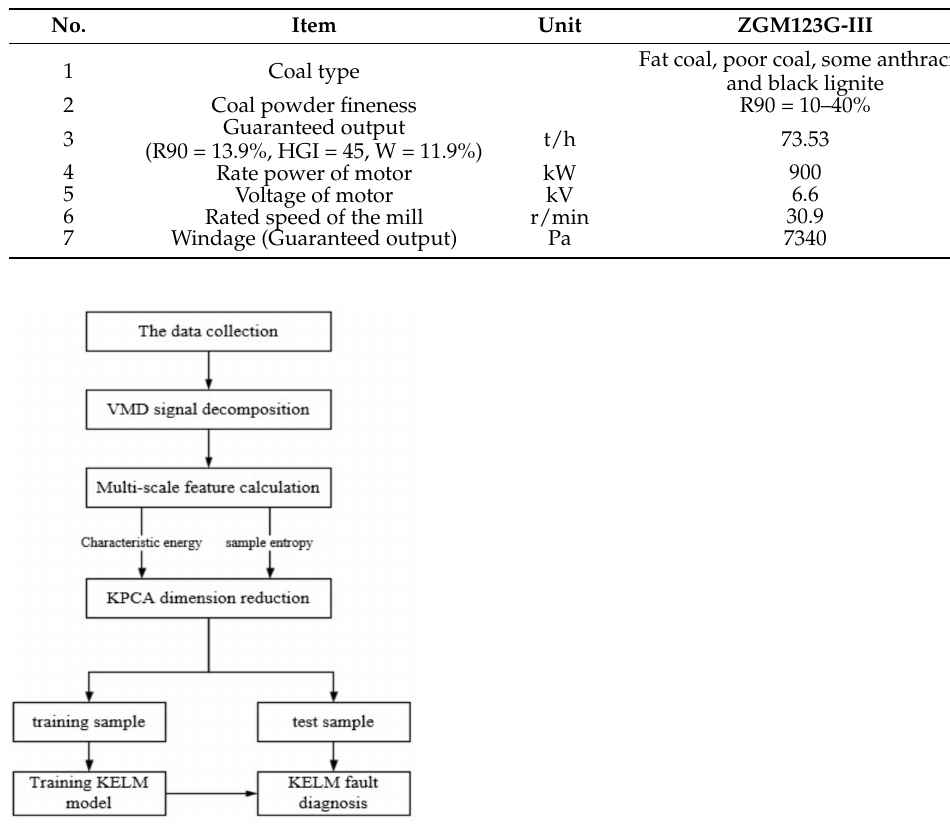
Table 2. The coal mill parameters.